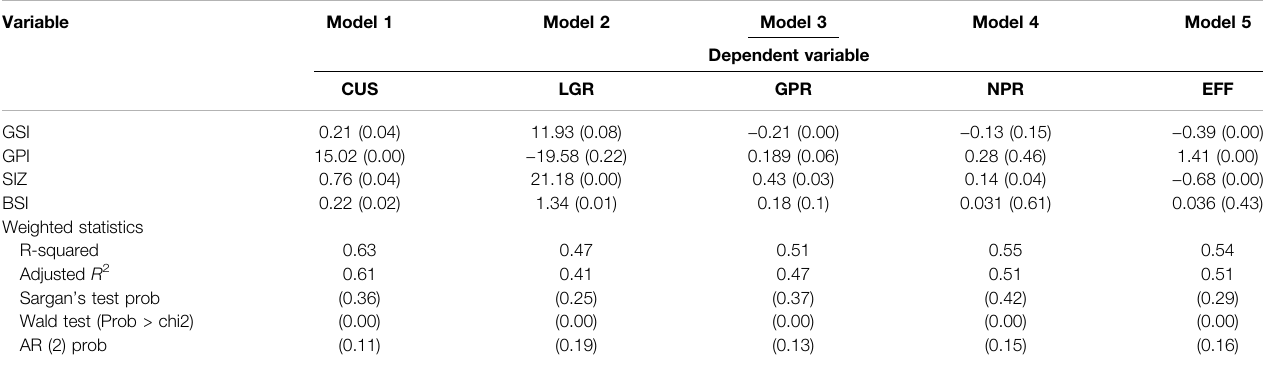
TABLE 3 | GMM panel regression results.